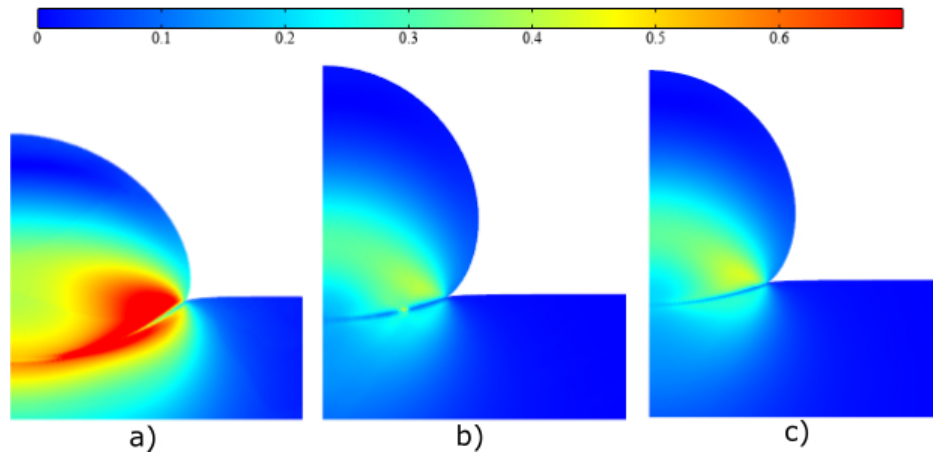
Figure 8. Equivalent plastic strain at the moment of maximum indentation for particle sizes ( a ) 1 µ m, ( b ) 30 μ m, and ( c ) 100 μ m.